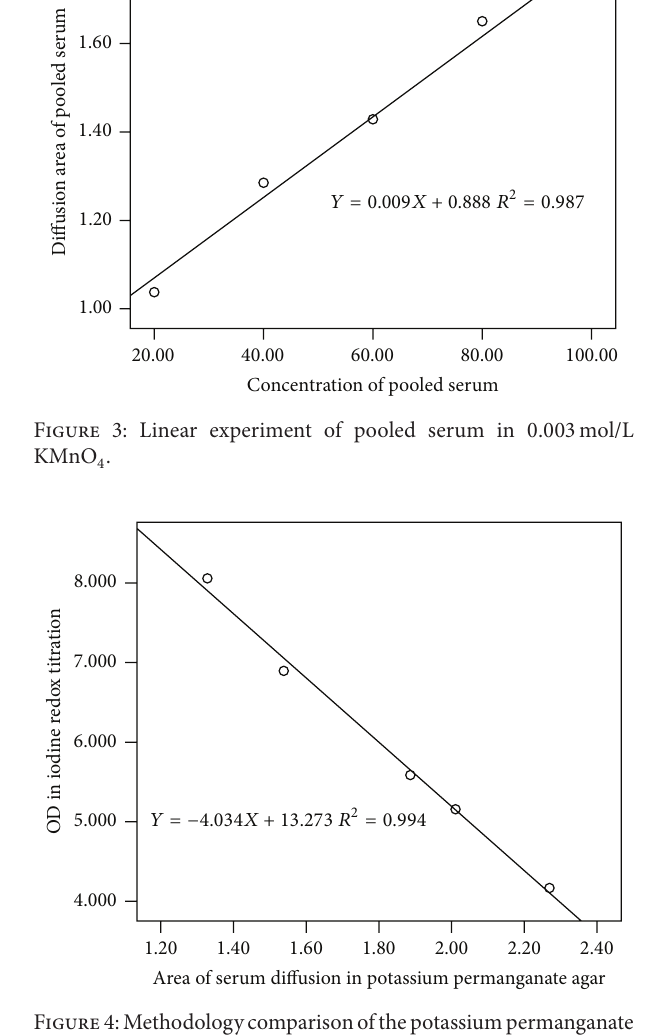
Figure4:Methodologycomparisonofthepotassiumpermanganate agar and the iodine redox